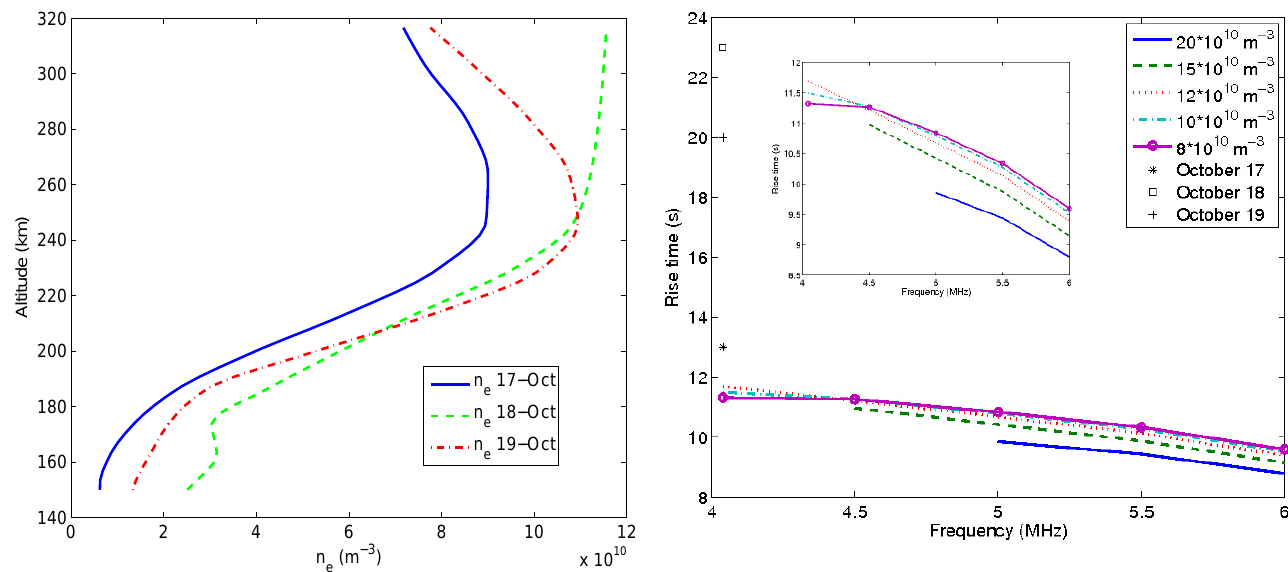
Fig. 5. Electron density profiles used for the simulations.